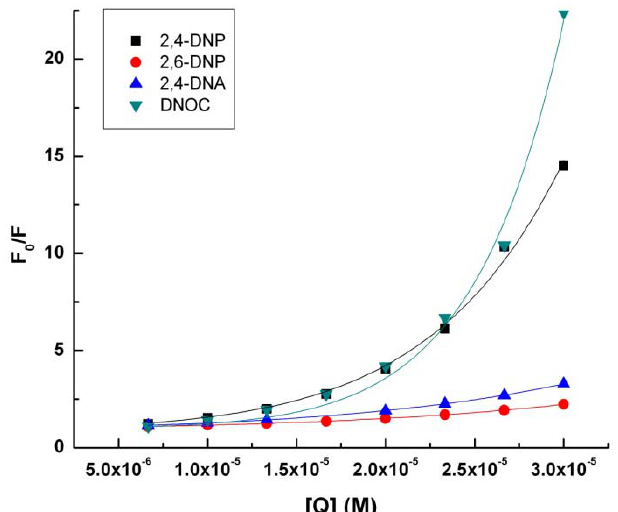
Figure 3. Stern-Volmer representation (2) for tryptophan (4.9 × 10 − 3 M) in presence of 2,4-DNP, 2,6-DNP, 2,4-DNA,